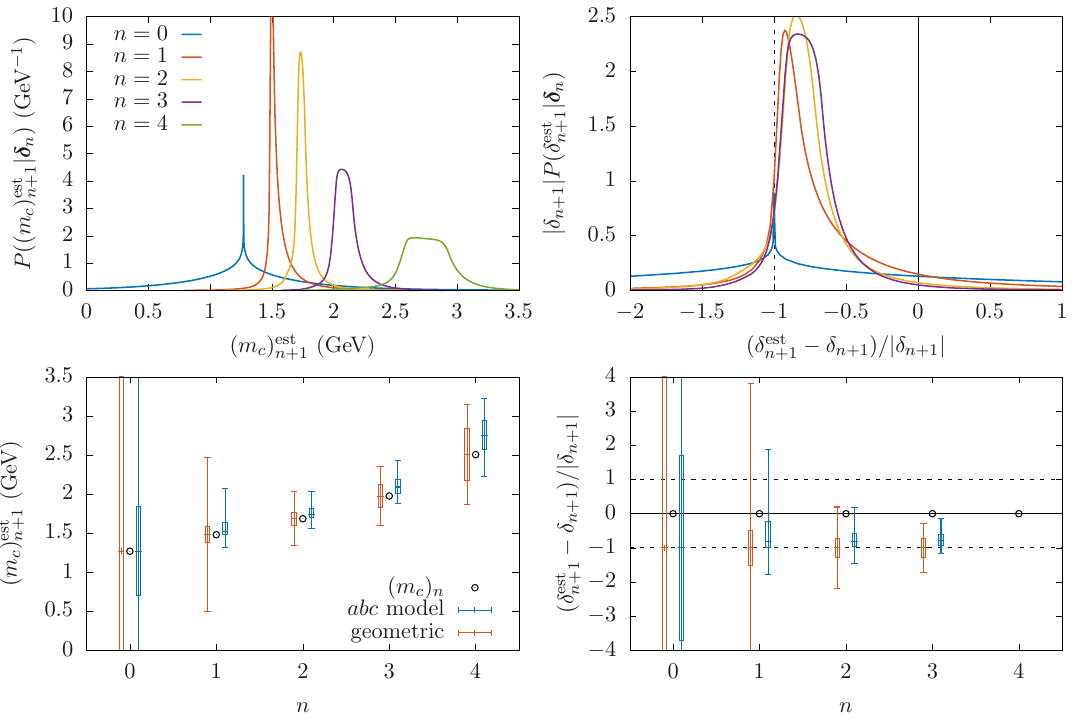
Figure 27 . The probability distributions and CIs for charm quark mass. See caption of figure